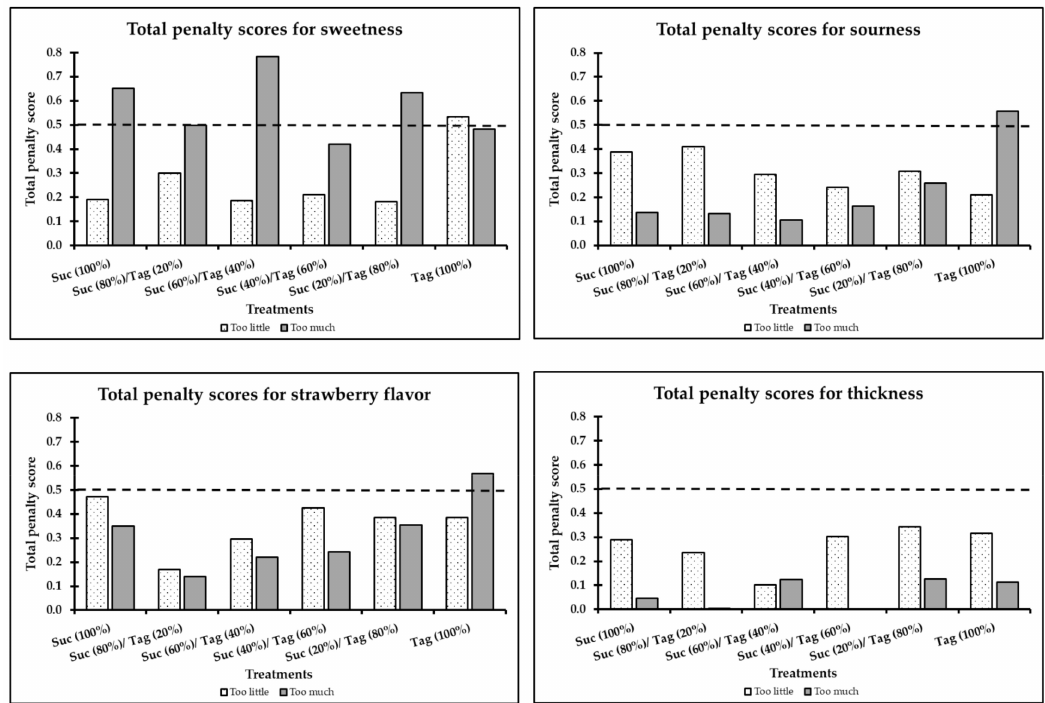
Figure 3. Total penalty scores in overall taste liking for sweetness, sourness, strawberry flavor, and thickness of strawberry-flavored yogurt samples (treatment labels are shown in Table 1).